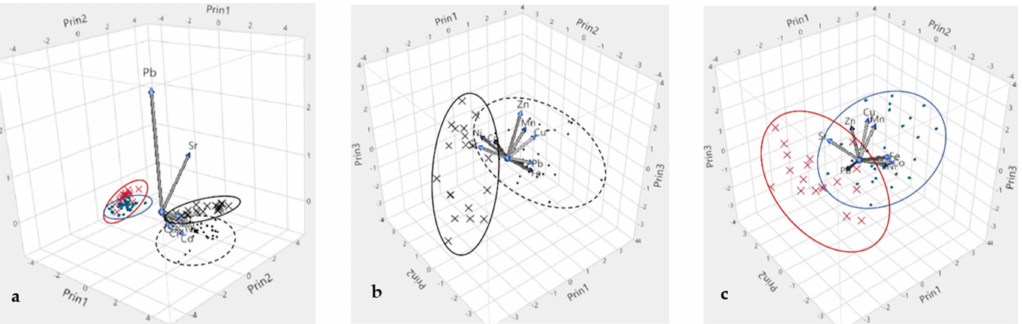
Figure 2. 3D Scatterplot showing Principal 1, Principal 2, and Principal 3: ( a ) Pre-harvesting and Post-harvesting stages; ( b ) Pre-harvesting stage; ( c ) Post-harvesting stage. (Key: × represents data from Field A pre-harvesting stage encircled in a black cluster; • represents data from Field B pre- harvesting stage encircled in a black dashed cluster; × represents data from Field A post-harvesting stage encircled in a red cluster; • represents data from Field B post-harvesting stage encircled in a blue